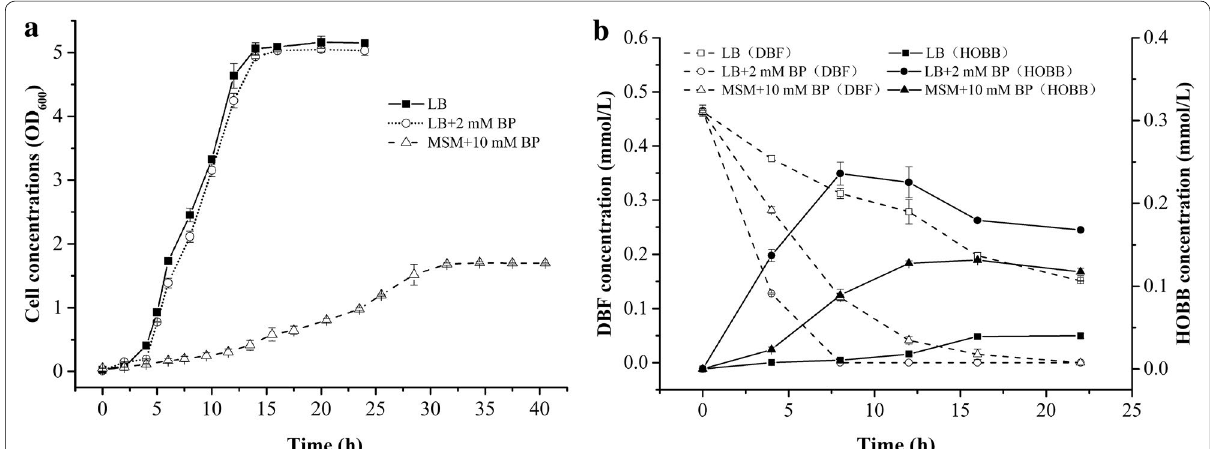
Fig. 2 Preparation of biocatalyst using different media. a Growth curves of strain B6-2 in three different media: LB medium (closed square), LB medium with 2-mM BP (open circle), and MSM with 10-mM BP (open triangle). b DBF degradation (dotted line) in LB medium (open square), LB medium with 2-mM BP (open circle) and MSM with 10-mM BP (open triangle), and HOBB accumulation (solid line) in LB medium (closed square), and LB medium with 2-mM BP (closed circle) and MSM with 10-mM BP (closed triangle) after cultivation of strain